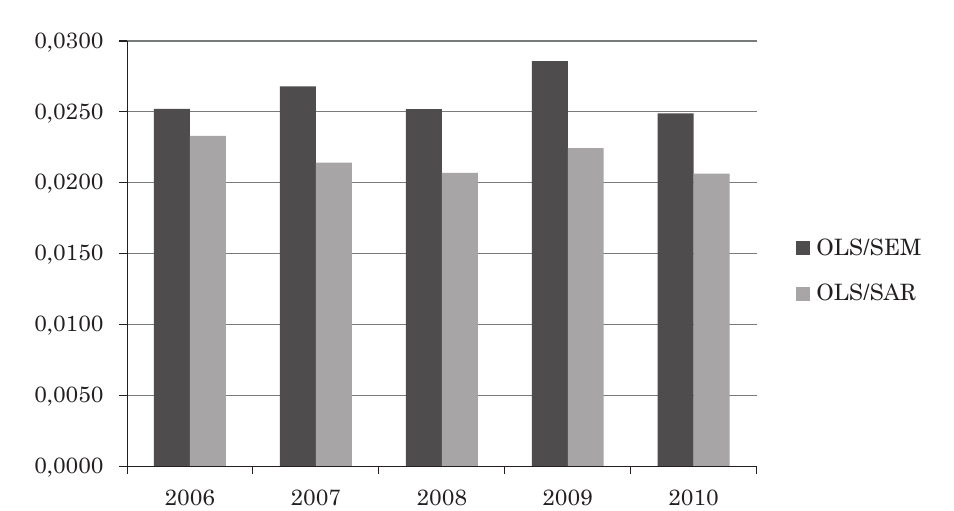
Figure 3. The average difference (absolute value) for each of the 66 labor markets between OLS estimates and SAR and